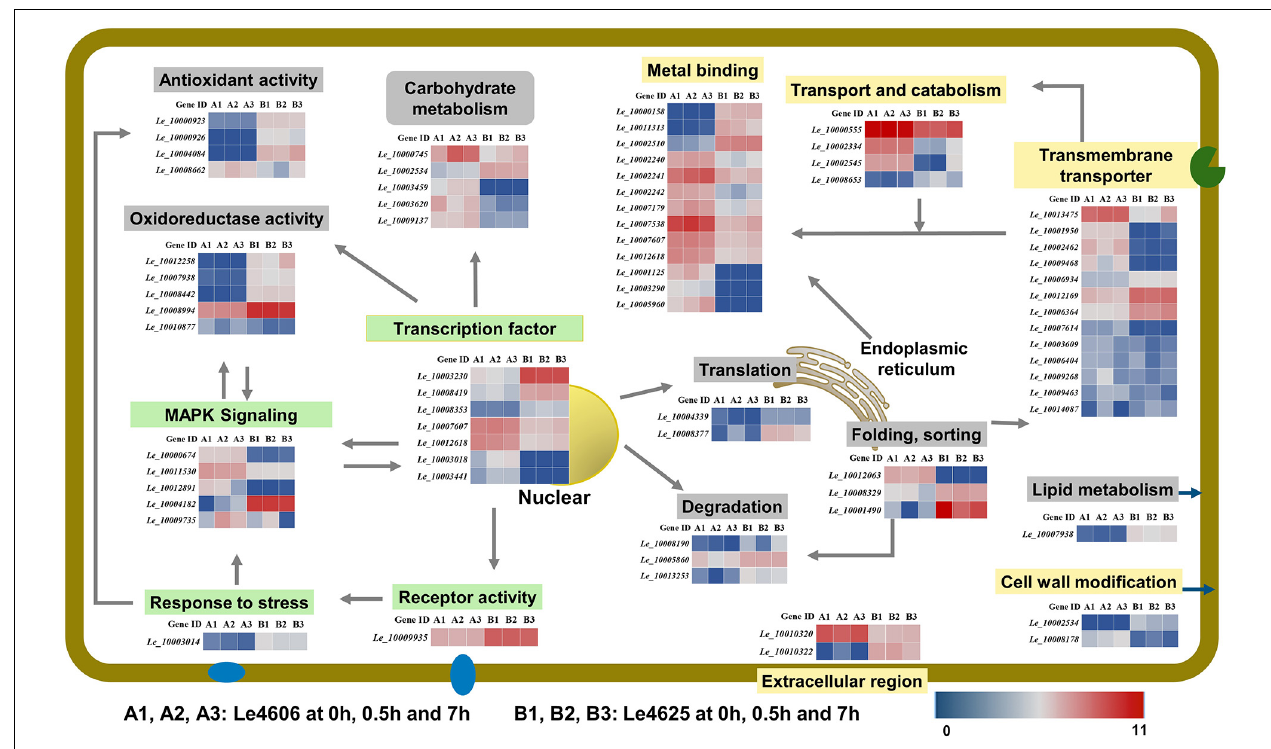
FIGURE 6 | Transcriptional changes of genes involved in Cd enrichment in the two L. edodes genotypes. DEGs involved in Cd enrichment are represented in different colors. Genes that may directly respond to heavy metals are shown in a yellow box; Genes involves in signal transduction are shown in a green box. Other genes are shown in gray. For signal transduction, the arrows represent the direction of signaling. For transporters, the arrows represented the directions of Cd transport. For transcriptional factors, the arrows pointed to the products of transcriptions.